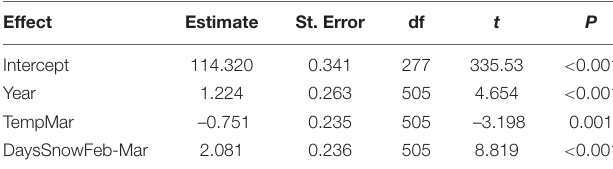
TABLE 3 | Fixed effects estimated (method: REML) for the best model based on AIC c : Hatchdate ∼ year + TempMar + DaysSnowFeb-Mar, with nesting territory as a random